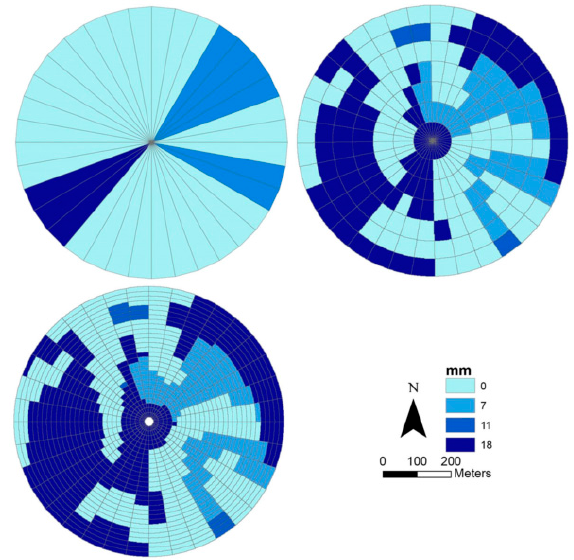
Figure 1. Prescription maps with different control scenarios for four irrigation depths ([48], reproduced with permission from Springer Nature).